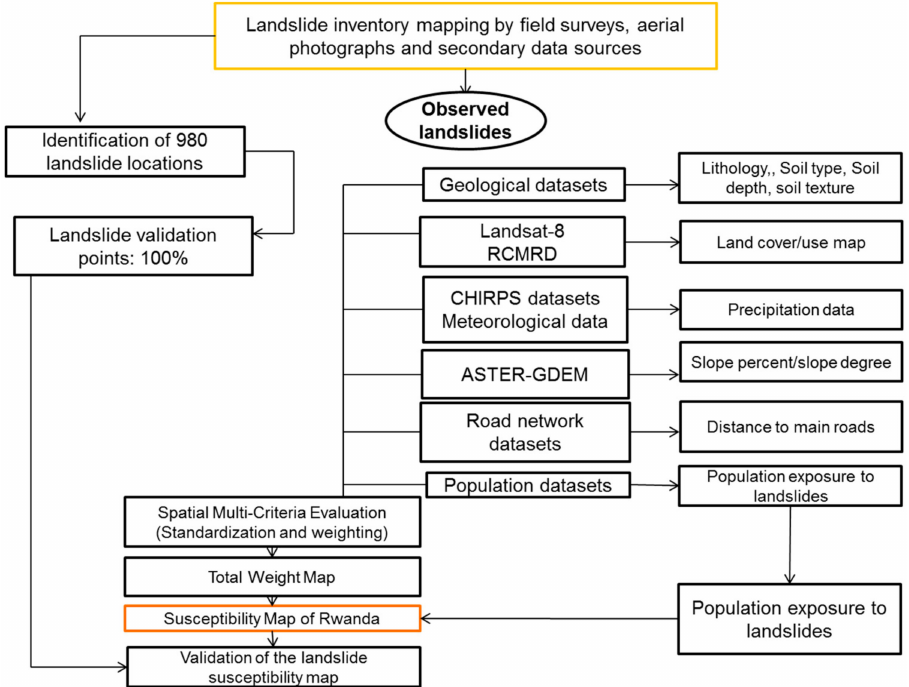
Figure 7. Flowchart of